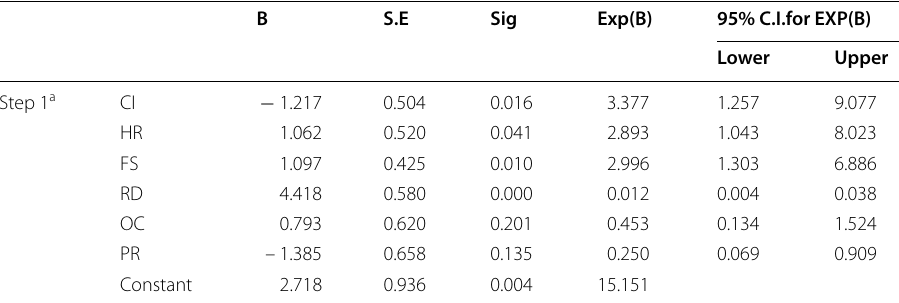
Table 6 Results of the logit model of deterrents to innovation of